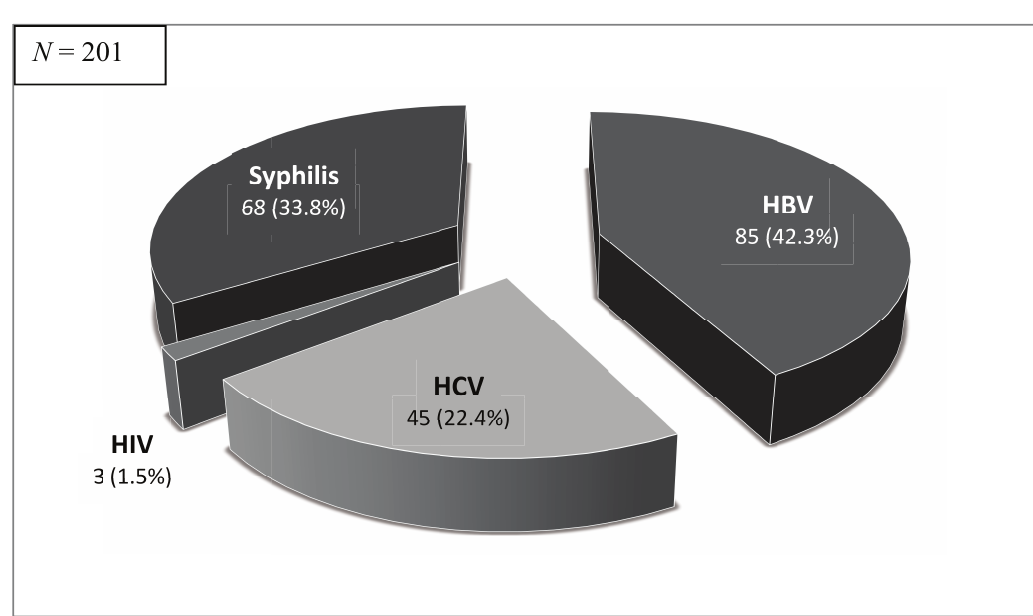
Figure 1: Distribution of Hepatitis B virus (HBV), Hepatitis C virus (HCV), Human Immunodeficiency virus (HIV), and syphilis among seropositive blood donors at Dongola Specialized Hospital, Sudan, 2010–2015.